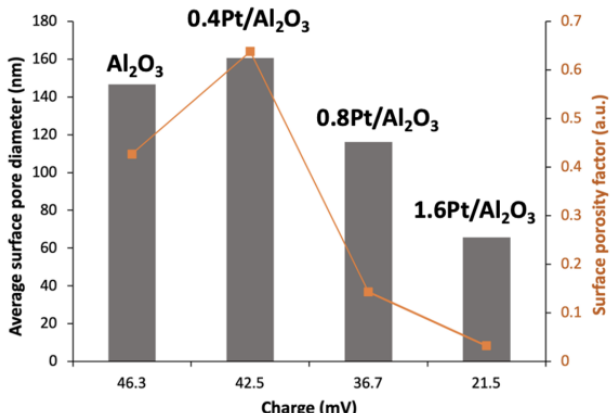
Figure 4. Average surface pore diameter (gray columns) and surface porosity factor (orange line) for different loadings of Pt (which correspond to a different templating colloid charge). Size and morphology of the SD powders were analyzed using ImageJ image processing software. At least 80 microparticles were analyzed.